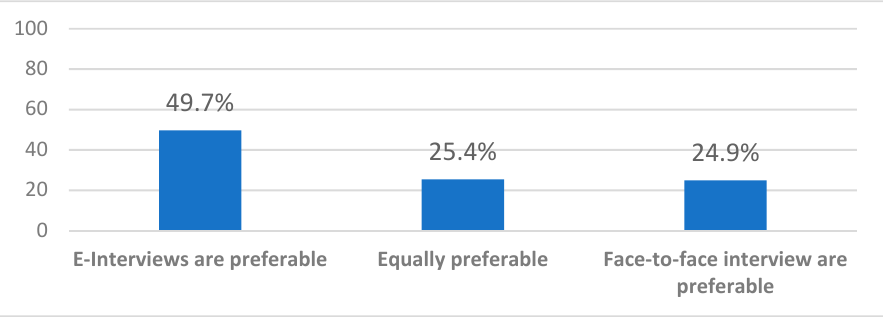
Figure 6. Faculty members overall rating of the virtual interview experience.